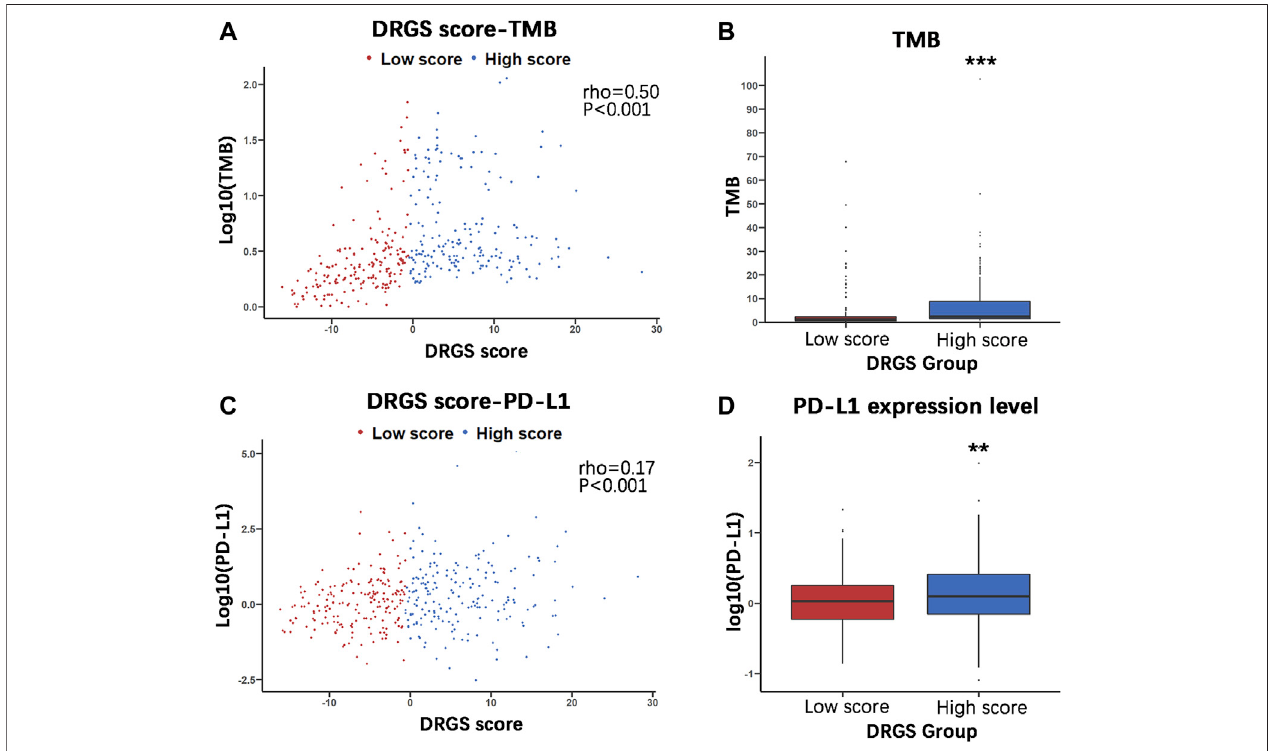
FIGURE 6 | Molecular characteristics of the two DRGS score groups (High score n = 183, Low score n = 182). (A) and (C) The Spearman ’ s correlation was performed to analyze the relationship between the DRGS score and two important immunotherapy biomarkers, TMB and PD-L1; (B) and (D) The Mann Whitney U test was used to compare TMB and PD-L1 expression in high and low score groups in TCGA-STAD gastric cancer samples. (* p < 0.05, ** p < 0.01, *** p < 0.001).